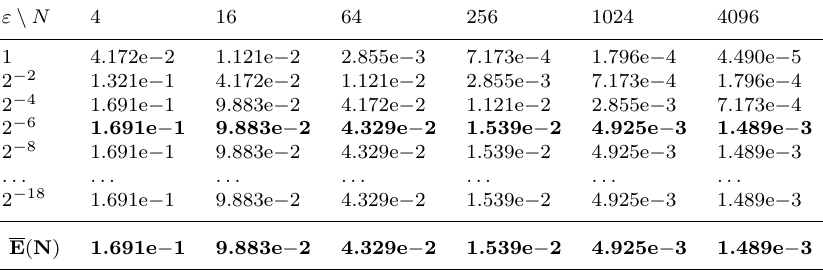
Table 2. Maximum point-wise errors E ( ε, N ) and E ( N ) in the solution of the standard scheme (4.2) on the special piecewise-uniform grid (5.1) ε \